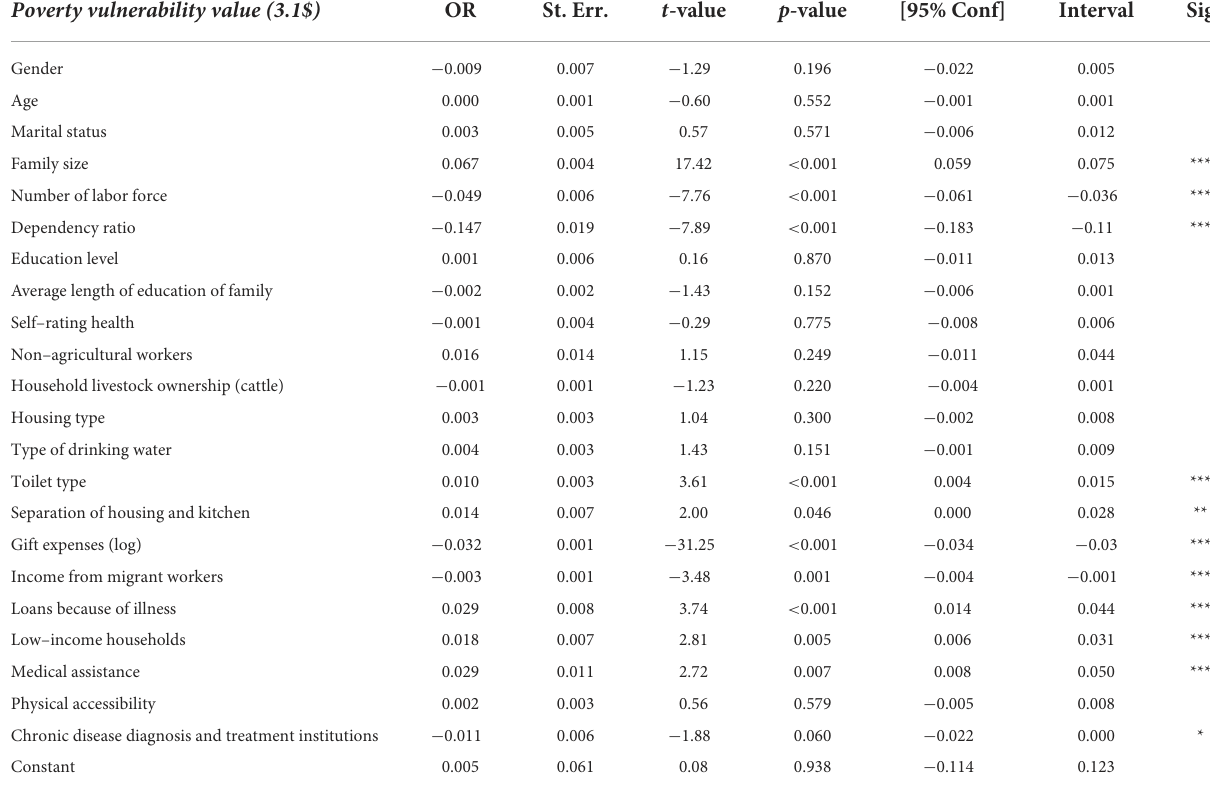
TABLE 3 Analysis on influencing factors of poverty vulnerability